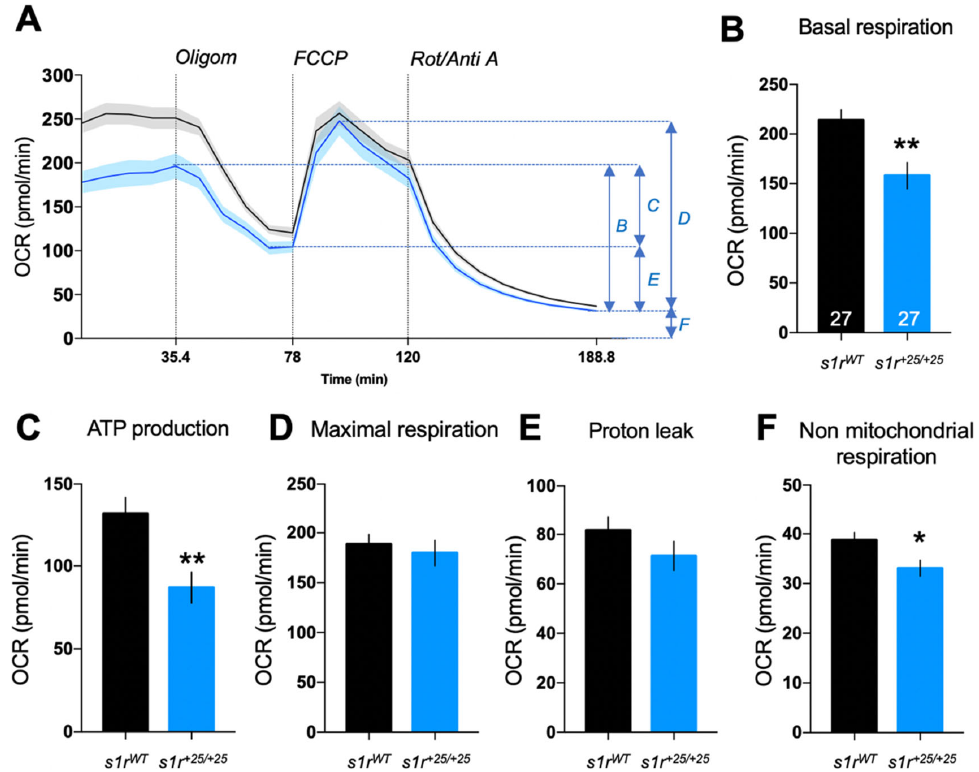
Figure 6. Analysis of mitochondrial respiration by the zebrafish larvae at 5 dpf analyzed using the Seahorse XF mito stress test. ( A ) Seahorse diagram depicting profile of oxygen consumption rate (OCR) during the assay. Letters ( B – F ) indicate the OCR components detailed in panels ( B – F ). ( B ) Basal respiration, ( C ) ATP production, ( D ) maximal respiration, ( E ) proton leak, ( F ) non ‐ mitochondrial respiration. Data are shown as mean ± SEM from the number of larvae indicated in ( B ). Abbreviations: Oligom, oligomycin (25 μ M); FCCP, carbonyl cyanide ‐ p ‐ trifluoromethoxyphenylhydrazone (8 μ M); Rot/AntiA, rotenone + antimycin A (15 μ M). * p < 0.05, ** p < 0.01; unpaired t ‐ test.